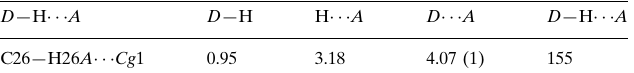
Hydrogen-bond geometry (A˚ , (cid:1) ). Cg 1 is the centroid of the imidazole